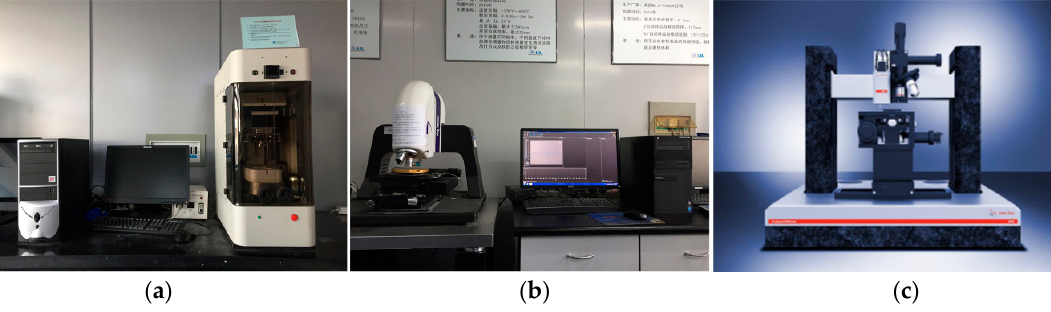
Figure 5. Experimental setup. ( a ) UMT-3 friction and wear testing machine, ( b ) non-contact three-dimensional surface profiler, and ( c ) ultra-nanoindenter.